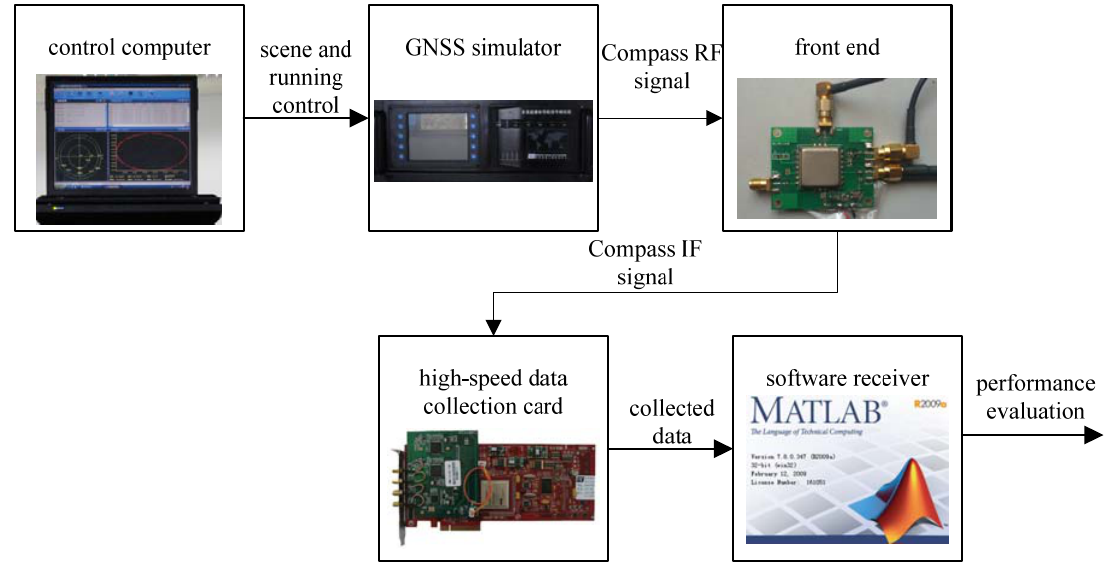
Figure 7. The test system composition based on GNSS simulator.